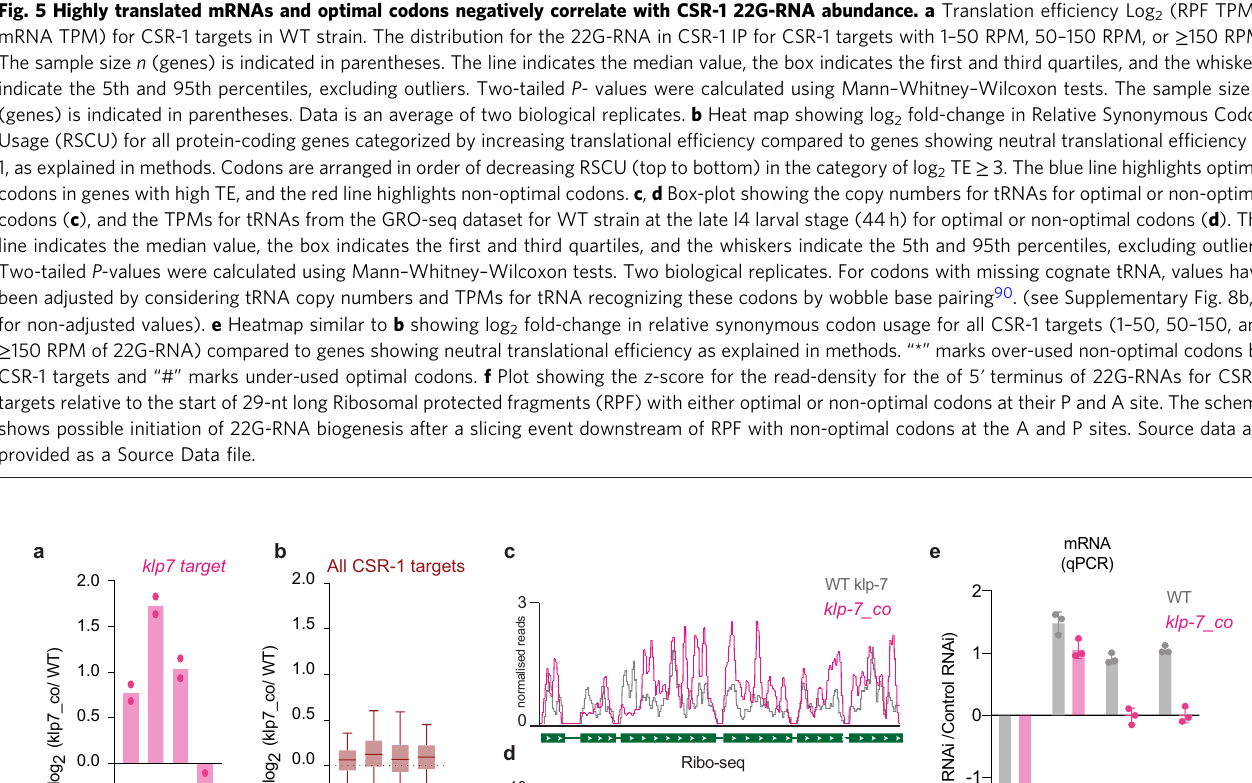
Fig. 6 Increasing optimal codon usage of CSR-1 target decreases small-RNA production. a , b Plot showing log 2 fold-change for normalized reads for mRNAs from RNA-seq, RPF from Ribo-seq, and 22G-RNAs from sRNA-seq and differential Translational ef fi ciency for klp-7 (top CSR-1 target) ( a ) and all CSR-1 targets (RPM ≥ 1, n = 4803) ( b ) for the strain with codon-optimized klp-7 ( klp7_co ) compared to WT strain. Two biological replicates are shown with their mean ( a ). For b , the line indicates the median value, the box indicates the fi rst and third quartiles, and the whiskers indicate the 5th and 95th percentiles, excluding outliers. Data is an average of 2 biological replicates. ( n = 4803 CSR-1 targets except klp-7). c , d A genomic view of klp-7 showing Ribo-seq ( c ) and 22G-RNAs ( d ), normalized reads for the strain with codon-optimized klp-7 ( klp7_co ) in pink compared to WT strain in gray. Data is average of two biological replicates. e Log 2 fold-change in expression of csr-1, glh-4 , and klp-7 upon csr-1 RNAi compared to control RNAi by qPCR in the WT strain and klp-7_co (strain with klp-7 codon optimization). Data are represented as mean ± SD for three biological replicates. Source data are provided as a Source Data